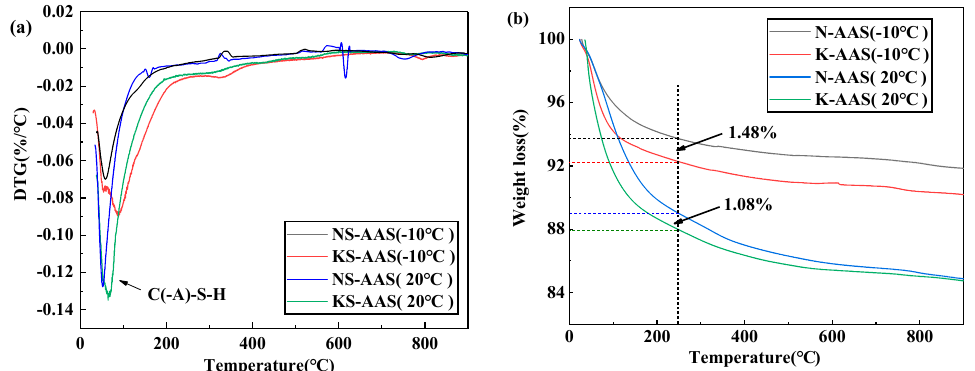
Figure 5. DTG/TG of AAS cured for 7d at temperatures of − 10 °C and 20°C. ( a ) DTG, ( b ) TG.